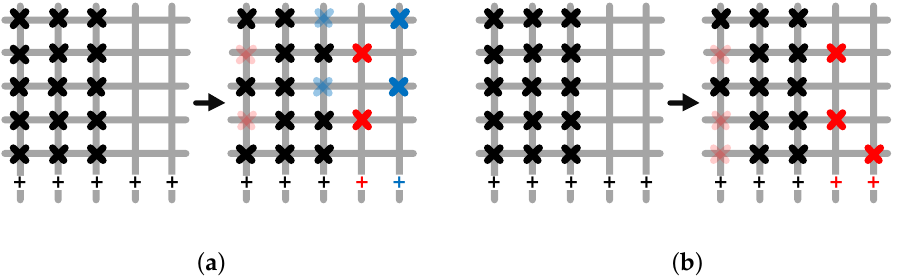
Figure 5. The two local decomposition methods: ( a ) k Split-in-Two (KS2). ( b ) One Split-in- k +1